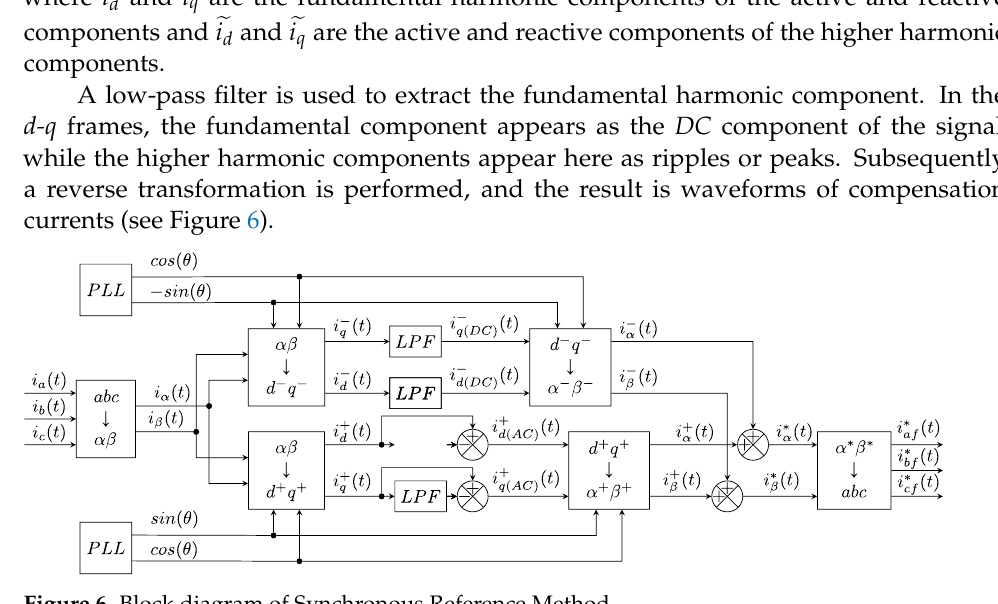
Figure 6. Block diagram of Synchronous Reference Method.